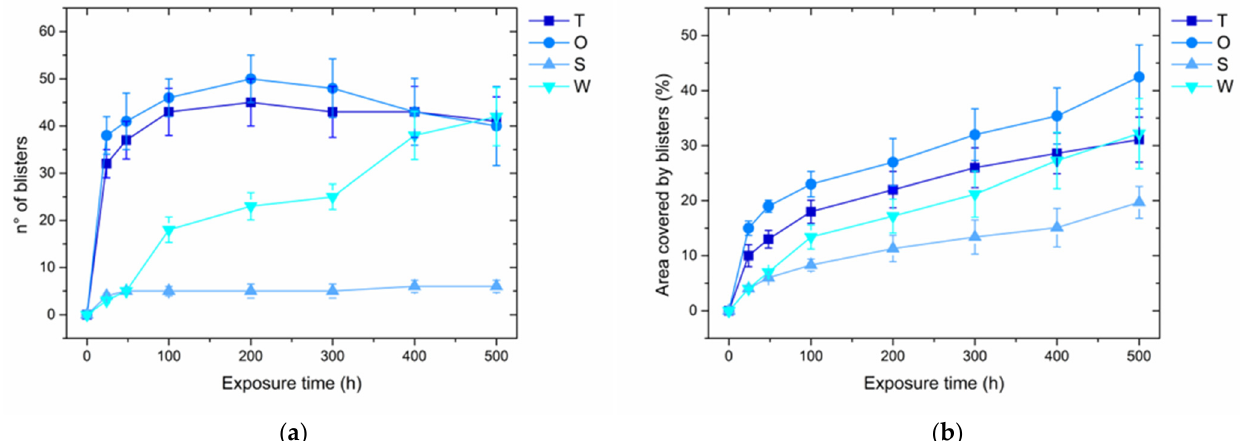
Figure 6. Evolution of ( a ) the number of blister and ( b ) the surface covered by blister during sample exposure in salt spray chamber.